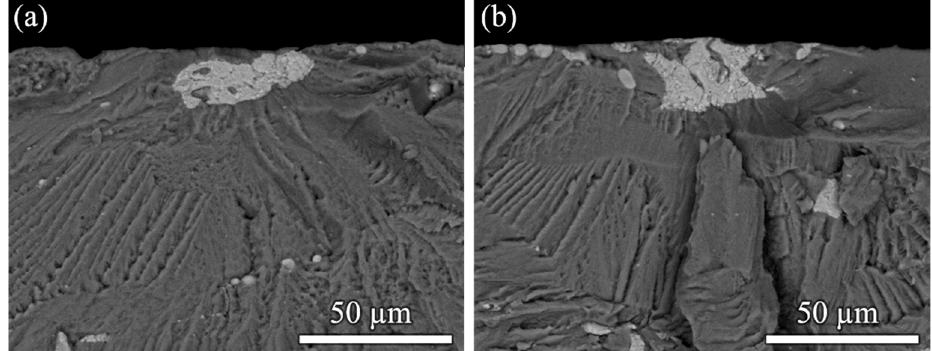
Figure 3. Fatigue crack initiation in 2024-T351 at a fractured secondary phase particle, probably Al 7 Cu 2 (Fe, Mn), cycling at stress amplitude 145 MPa ( a ) in ultrasonic test (1.8 × 10 5 cycles to failure) and ( b ) in servo-hydraulic test (9.1 × 10 4 cycles to failure).